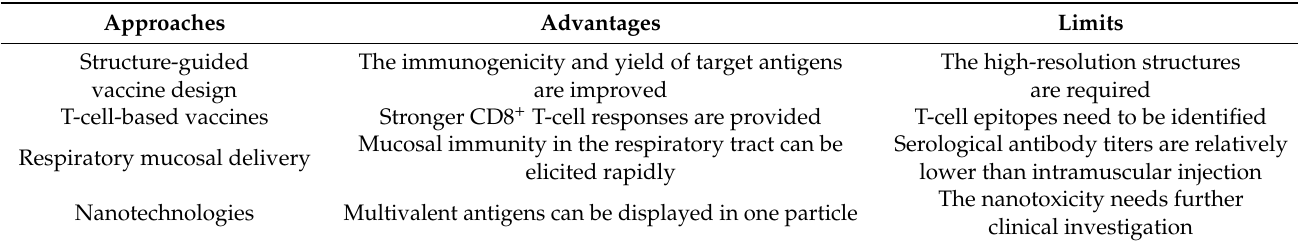
Table 2. Comparison of the four summarized vaccine design